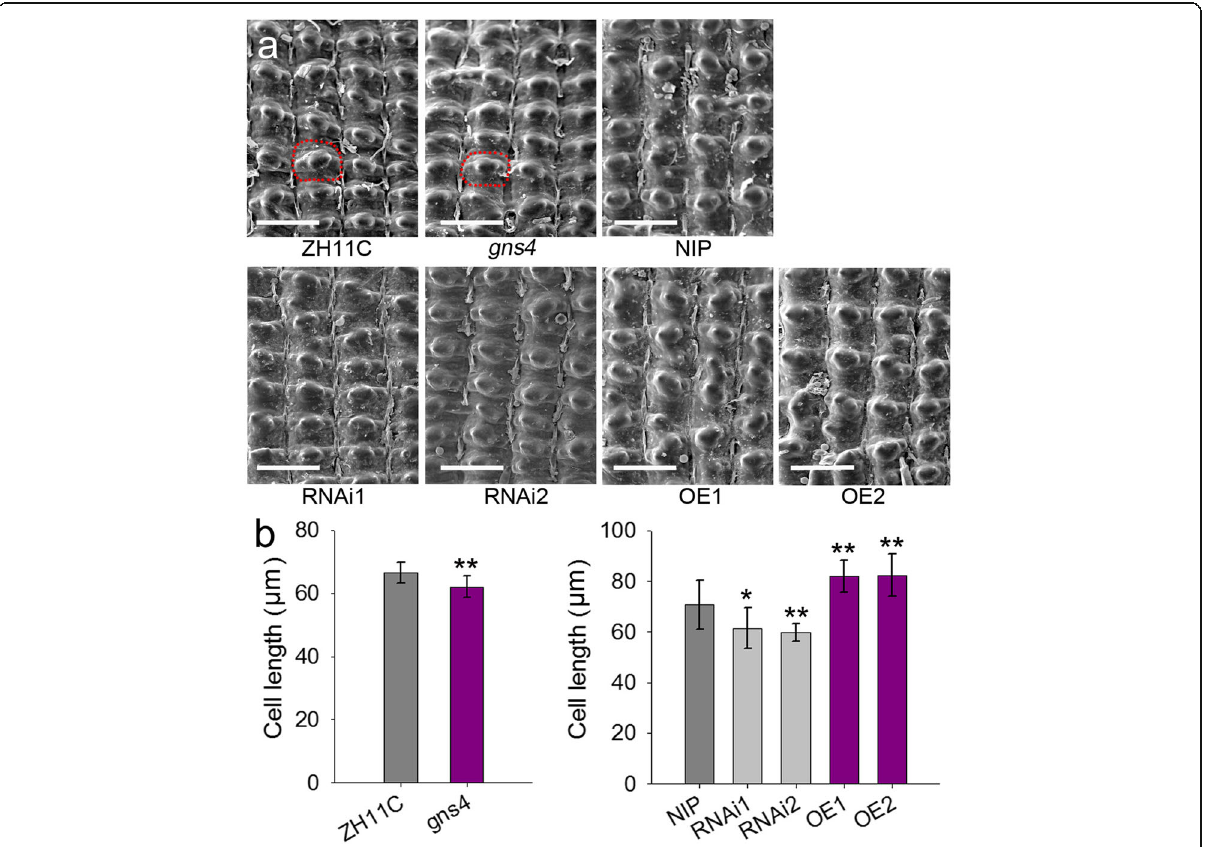
Fig. 4 The effect of GNS4 on cell size of glume. a Scanning electron microscope photographs of the glume outer surfaces of mature seeds. The outline of one glume cell in WT and gns4 hulls, respectively, is boxed by the red dotted line. Bar, 100 μ m. b Comparison of average length of outer glume surface cells. Data are shown as means ± s.e. ( n ≥ 10). Significant at **1% and *5%